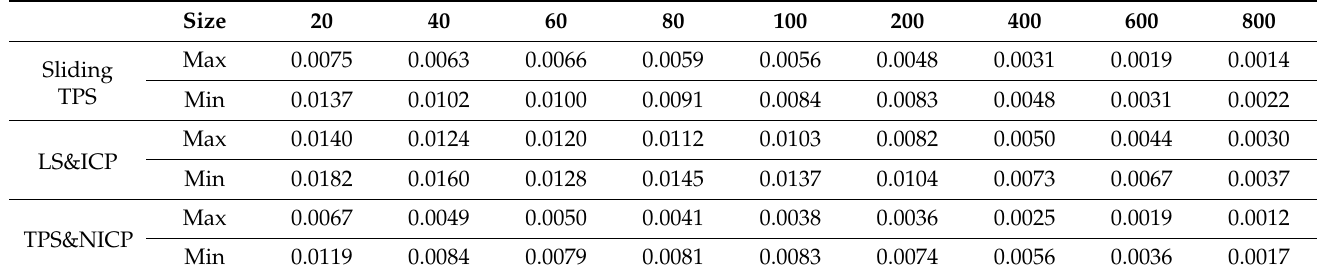
Table 7. Procrustes distances between vertices of the allometrically scaled surfaces of heads at the maximum and minimum centroid sizes using the landmarks and highest density of semiland- marks and surfaces estimated using the landmarks and lower densities of semilandmarks after re-semilandmarking and re-warping.